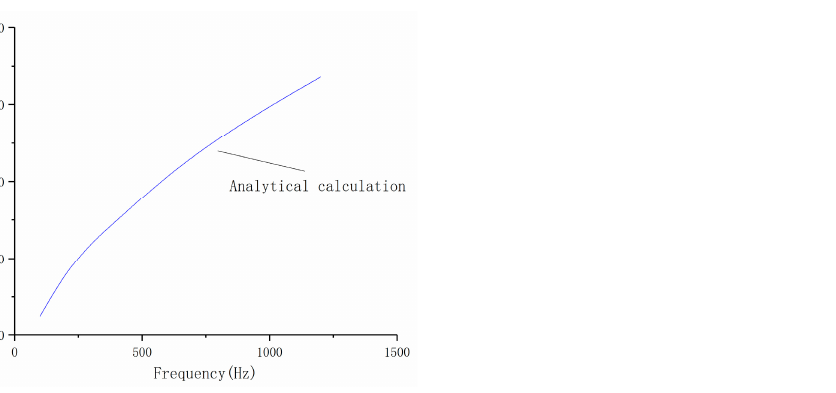
Figure 6. The variation of the rotor eddy current loss with frequency for a given load condition.